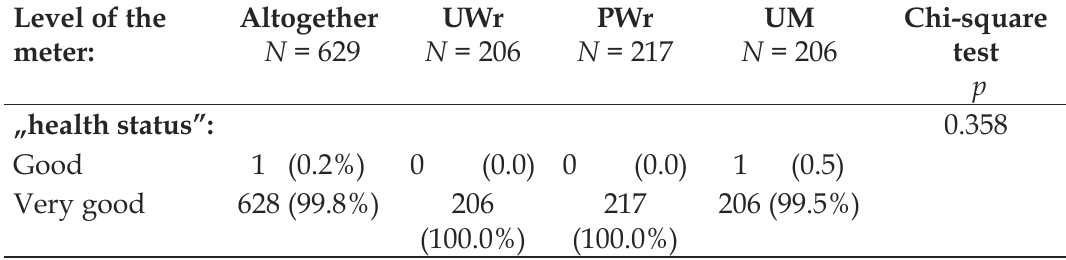
Basic statistics (numbers and proportions) of SPM level “health status”. Level of the